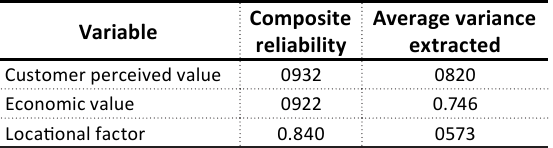
Table 14. Research model validity and reliability